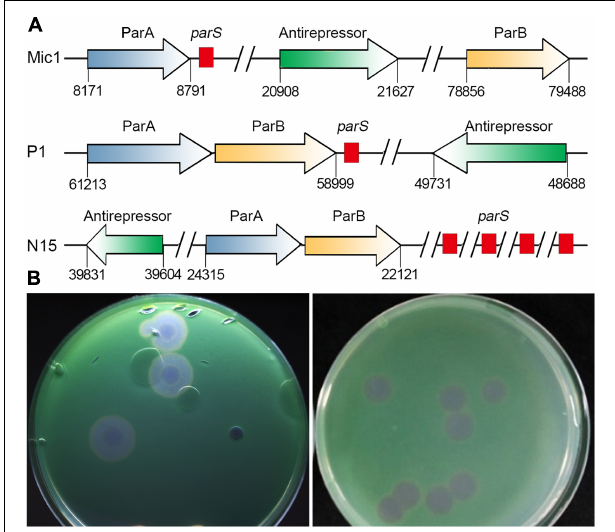
FIGURE 3 | Analyses of Mic1 ParABS system. (A) Partitioning loci location in Phages. Genes that encode ParA are depicted by blue arrows, ParB by yellow arrows, the sequences of parS are depicted by red box. Genes that encode antirepressor are depicted by green arrows. (B) The phage plaques of Mic1. Plaques in the left dish are at lysogenic status, featured with cloudy circular plaques with a bull’s eye at the center, whereas the clear plaques in the right dish are at lytic